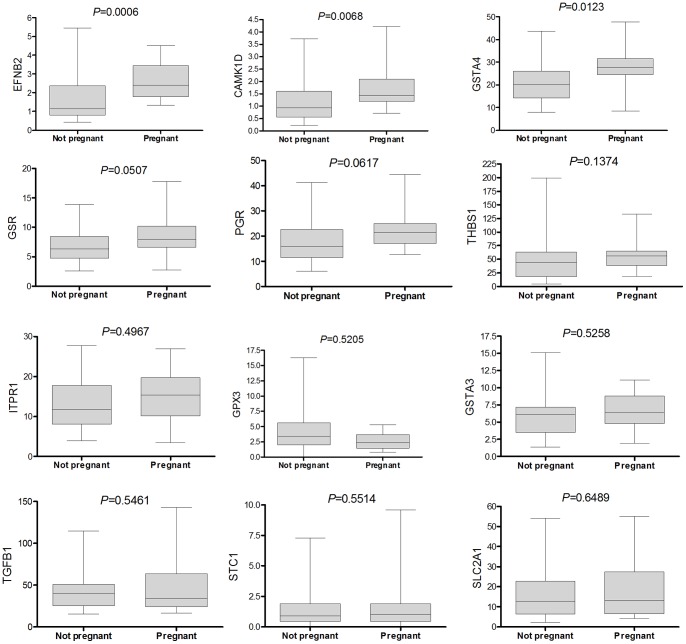
t-test of normalized gene expression values of non-pregnant versus live birth related cumulus cell samples.The graphs represent the differences in gene expression between the cumulus cell samples associated to an oocyte that after in vitro fertilization treatment resulted in a live birth (n = 19) or not (n = 28). Normalization was done to the mean of B2M and UBC. Only P-values <0.0042 were considered significant after Bonferroni correction. The total range of expressions found is depicted by the boxes and whiskers respectively representing the two inner and the two outer quartiles with centrally the median.